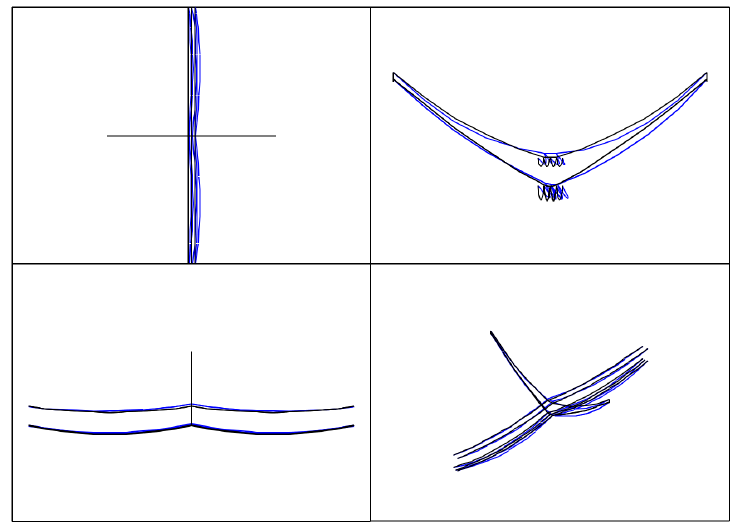
Figure 13. Unscaled deformation of long-span cross-rope suspension line by static wind load. (Dotted: undeformed. Solid: Deformed.)